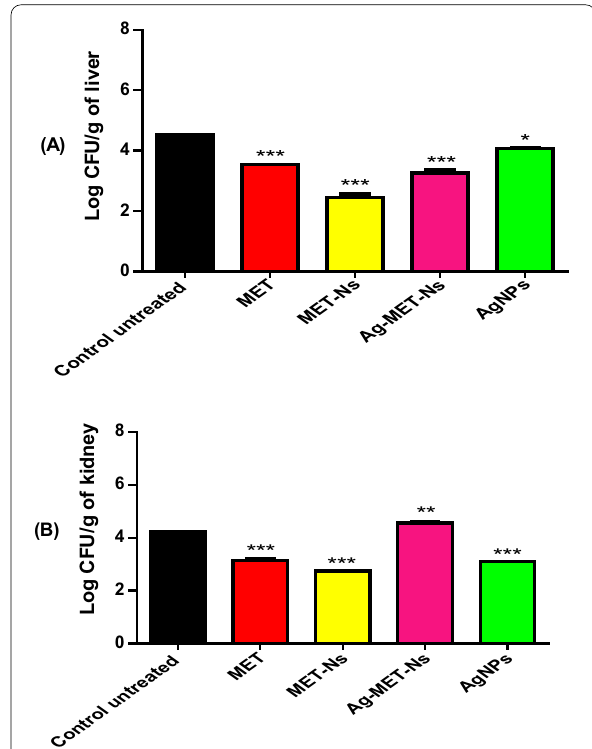
Fig. 5 Bacterial load reduction by tested agents. S. aureus ATCC 6538 CFUs recovered from livers ( A ) and kidneys ( B ) of mice tissues 24 h post-infection. Bars represent mean log CFUs/g of organ tissue. The bacterial load was calculated and expressed as means errors. * P <